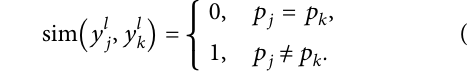
③ Q -value table fusion is: the feature vector is obtained